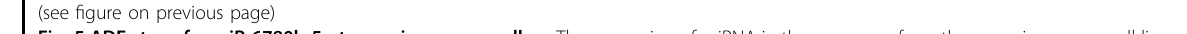
Fig. 5 ADEs transfer miR-6780b-5p to ovarian cancer cells. a The expression of miRNA in the exosomes from three ovarian cancer cell lines was compared with that in the cytoplasm, and samples with higher expression were selected. A total of 25 miRNAs were expressed in aggressive SKOV3- ip1 and HEYA8 cells but not in the less-invasive A2780 cells. b Thermograms of the seven miRNAs in ovarian cancer cells with the highest expression among the 25 miRNAs. c qRT-PCR was performed to detect the expression of the seven miRNAs in A2780 and CAOV3 cells treated with #7 or #27 ADEs. (miR-1825, miR-122-5p, and miR-4484 are not shown because their CT values were greater than 30). d Venn diagram of the downstream target genes of miR-6780b-5p, which were predicted with three common miRNA prediction websites: TargetScan, miRDB and RNA22. e GO (gene